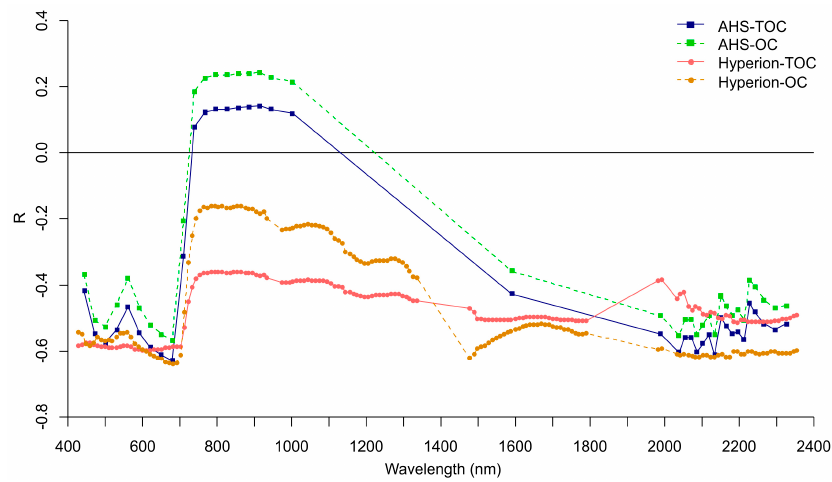
Figure 3. Pearson correlation coefficient between the TOC and OC content and the reflectance values from the AHS and Hyperion images.